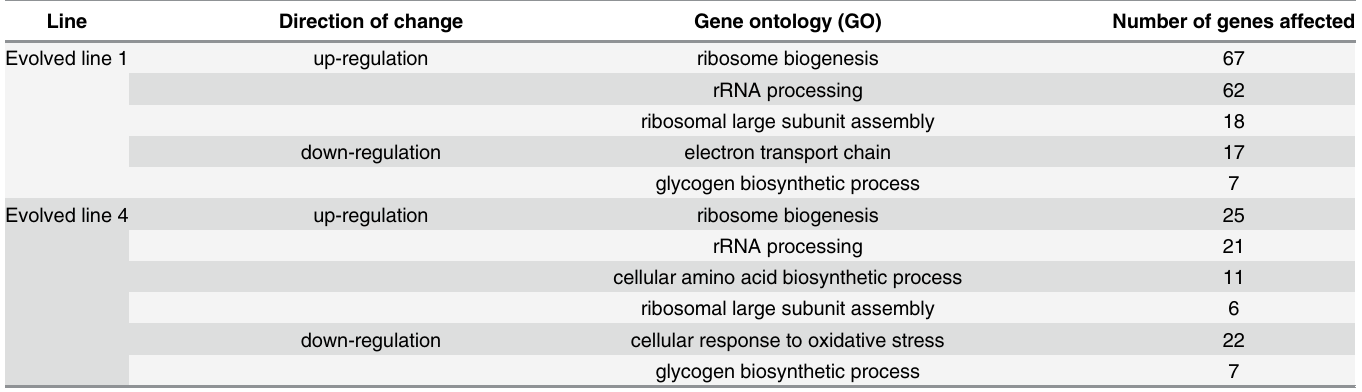
Table 2. Functional enrichment of genes showing altered transcription in the evolved lines relative to the ancestor.